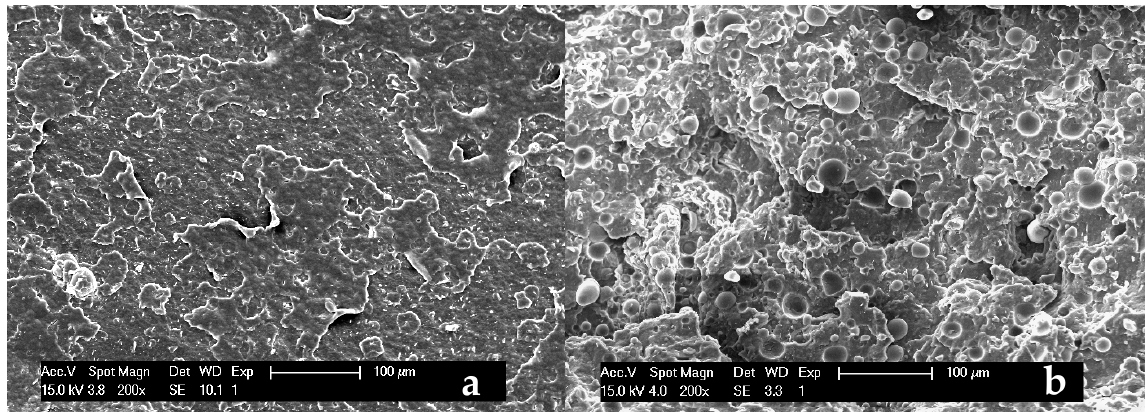
Figure 12. SEM pictures of fracture surfaces of ( a ) PHBV and ( b ) its biocomposite containing 20 wt% of sweet potato residue, at magnification 200×.